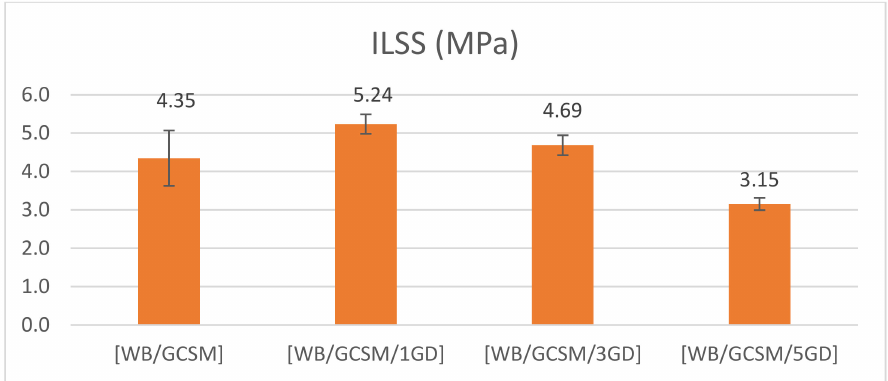
Figure 10. Interlaminar shear strength of [WB/GCSM], [WB/GCSM/1GD], [WB/GCSM/3GD] and [WB/GCSM/5GD]